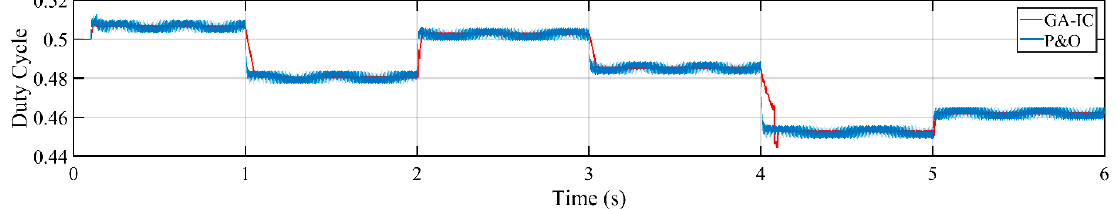
Figure 29. Case 2 current, detailed comparison of modified GA-IC vs. P&O.